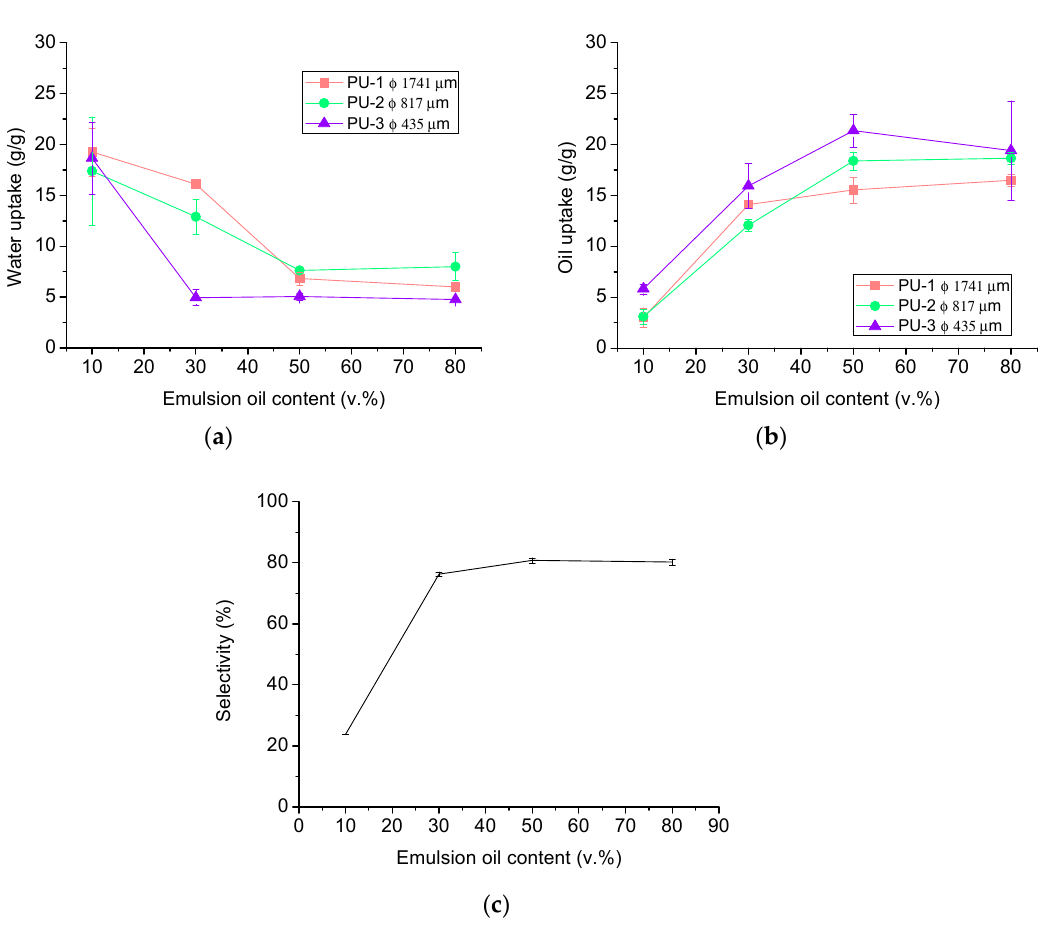
Figure 1. Simultaneous ( a ) water (w water ) and ( b ) oil uptake (w oil ) from stable water-in-oil emulsions using pristine PU foams with different pore sizes. Oil absorption selectivity ( c ) of PU-3 ( Φ = 435 µ m) from stable water-in-oil emulsions.